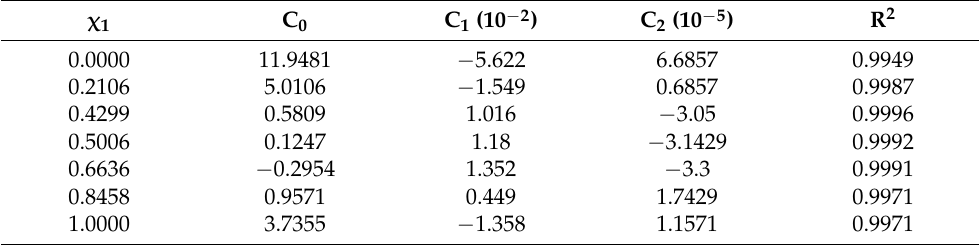
Table 7. The fitting parameters (C i ) and the determination coefficients (R 2 ) of Equation (5) for